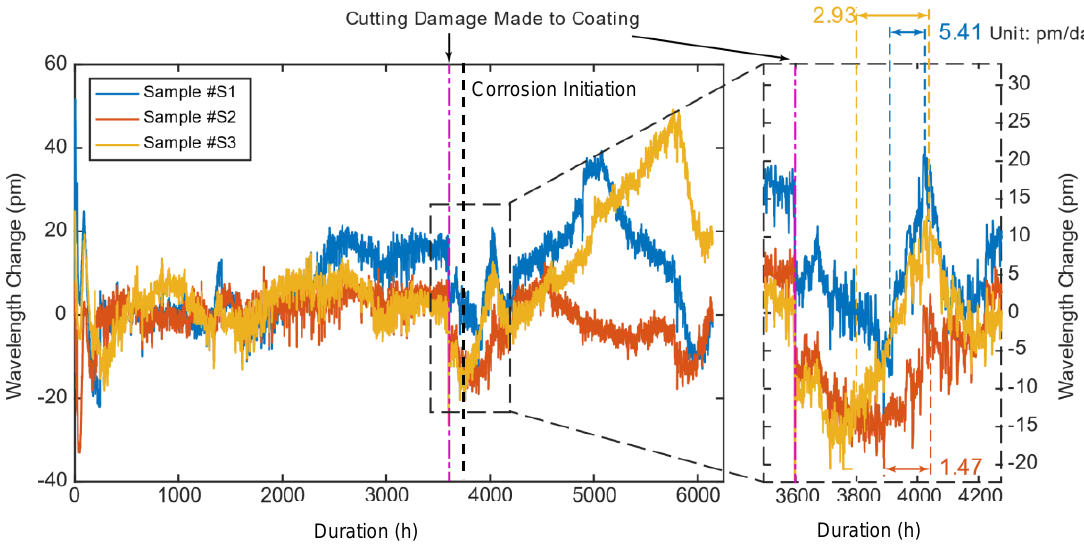
Figure 9. Bragg wavelength of embedded FBG sensors with polymeric coating with partial enlargement.